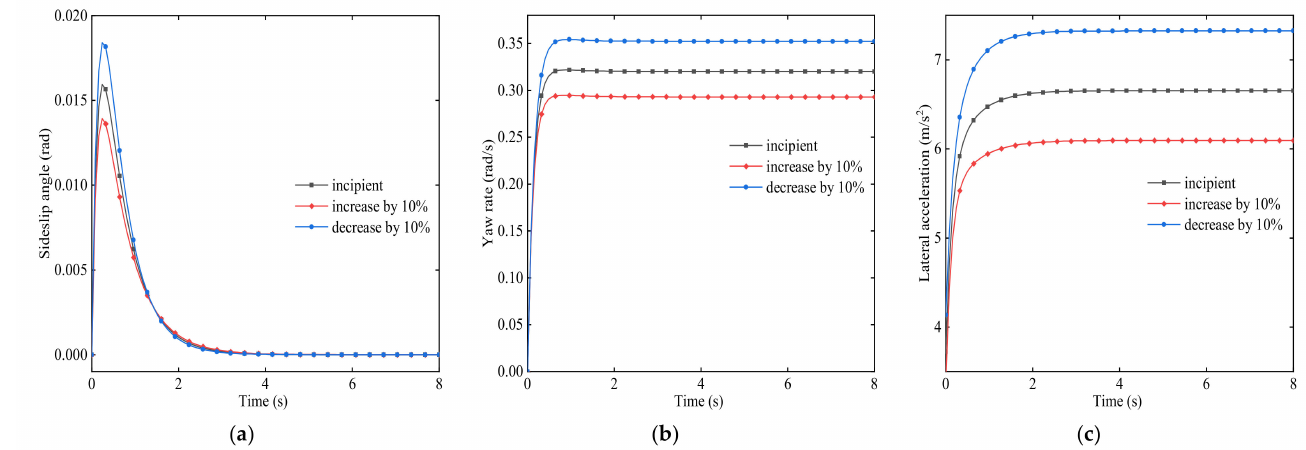
Figure 18. Simulation comparison of quality change. ( a ) Sideslip angle. ( b ) Yaw rate. ( c ) Lateral acceleration.